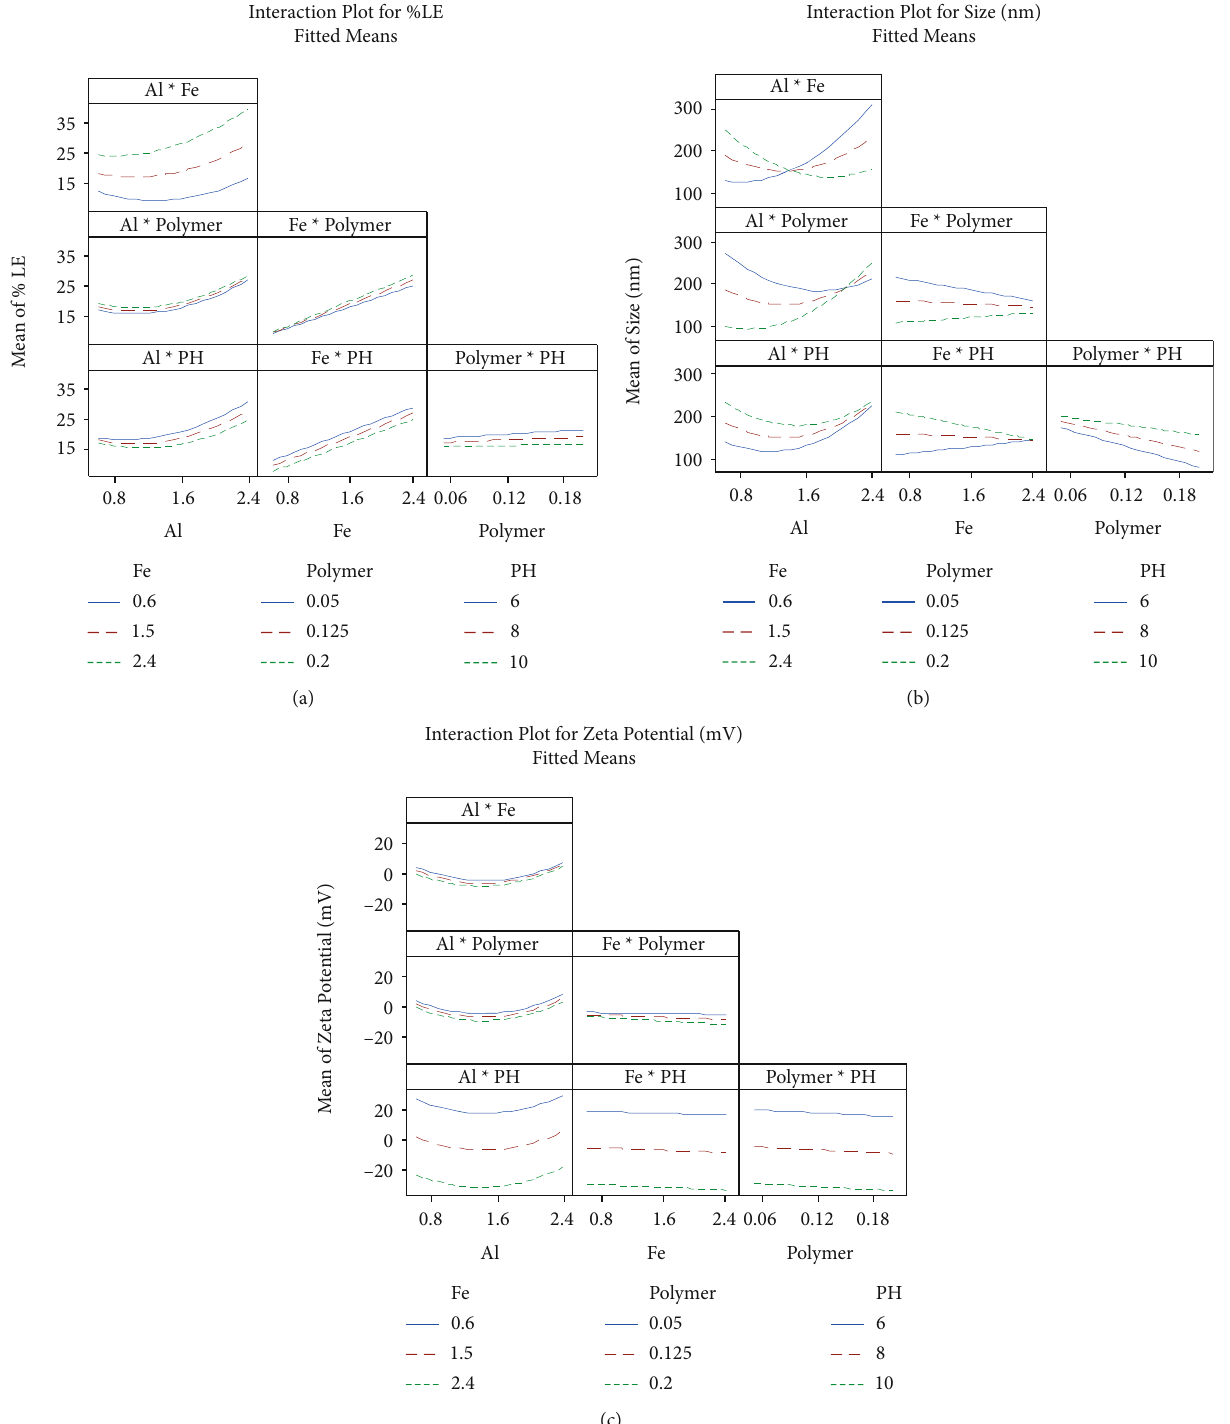
Figure 4: (a) Interaction plots for %LE, (b) particle size, and (c) zeta